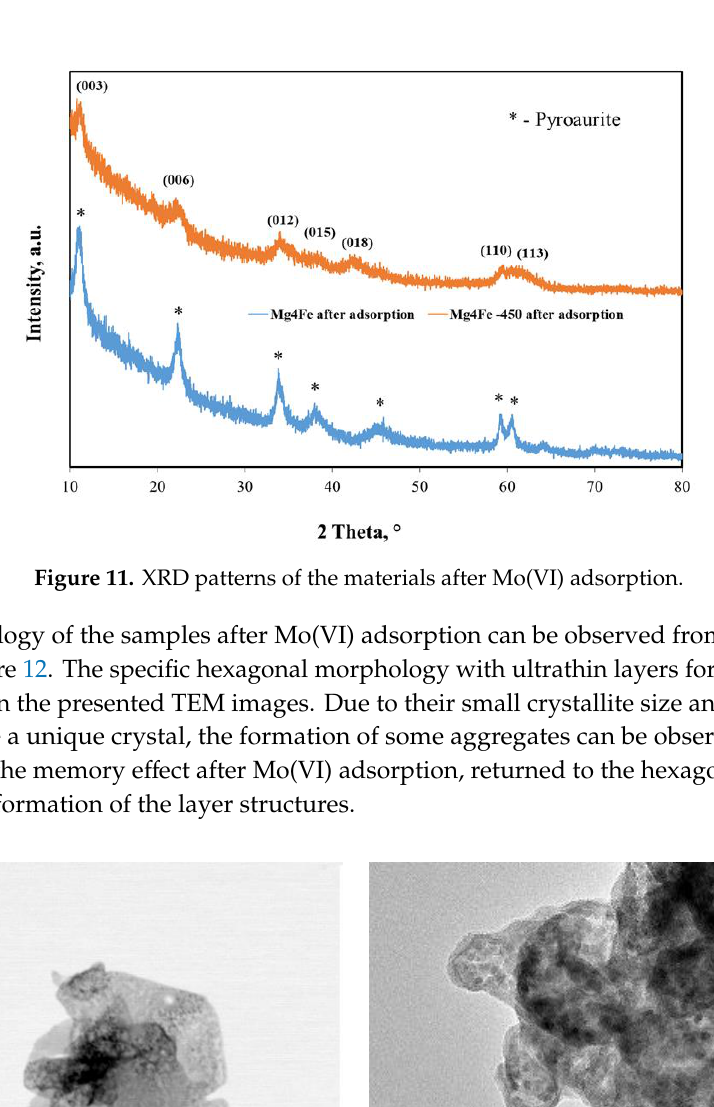
Table 6. The comparison between the adsorption capacities of similar adsorbents developed for the treatment processes of aqueous solutions containing MoO 42− anions.